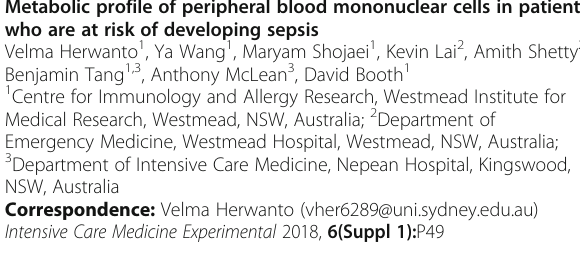
Table 1 (abstract P48). Characteristics of Included